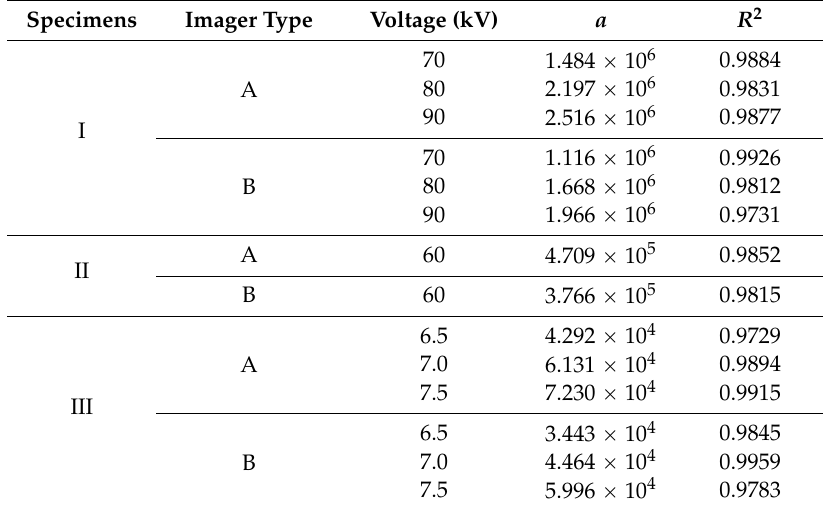
Table 5. Fitting parameters of observation distance to photon